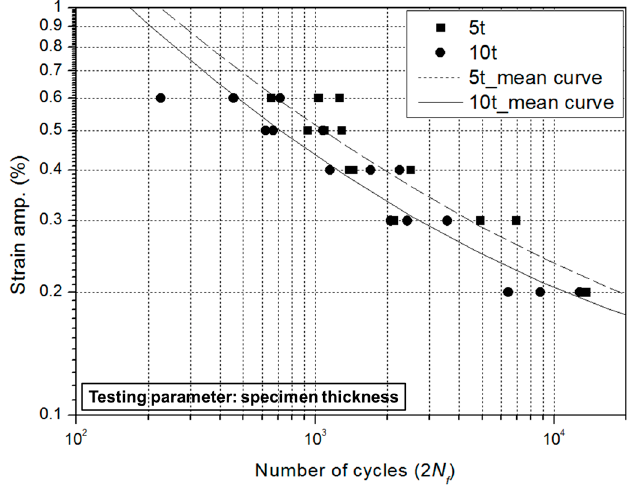
Figure 6. Strain–life curve for two different thicknesses under strain ratio R = 0.